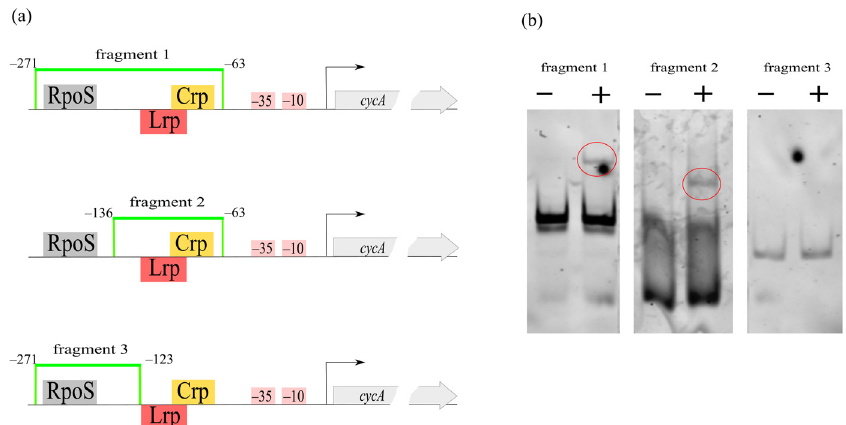
Figure 10. ( a ) A schematic view of cycA regulatory region with predicted regulator binding sites and DNA fragments used in EMSA with pure Crp protein. ( b ) EMSA results. ( − ) no Crp, only free probe; (+) samples with Crp; bands corresponding to retardation observed for fragments 1 and 2 are circled.